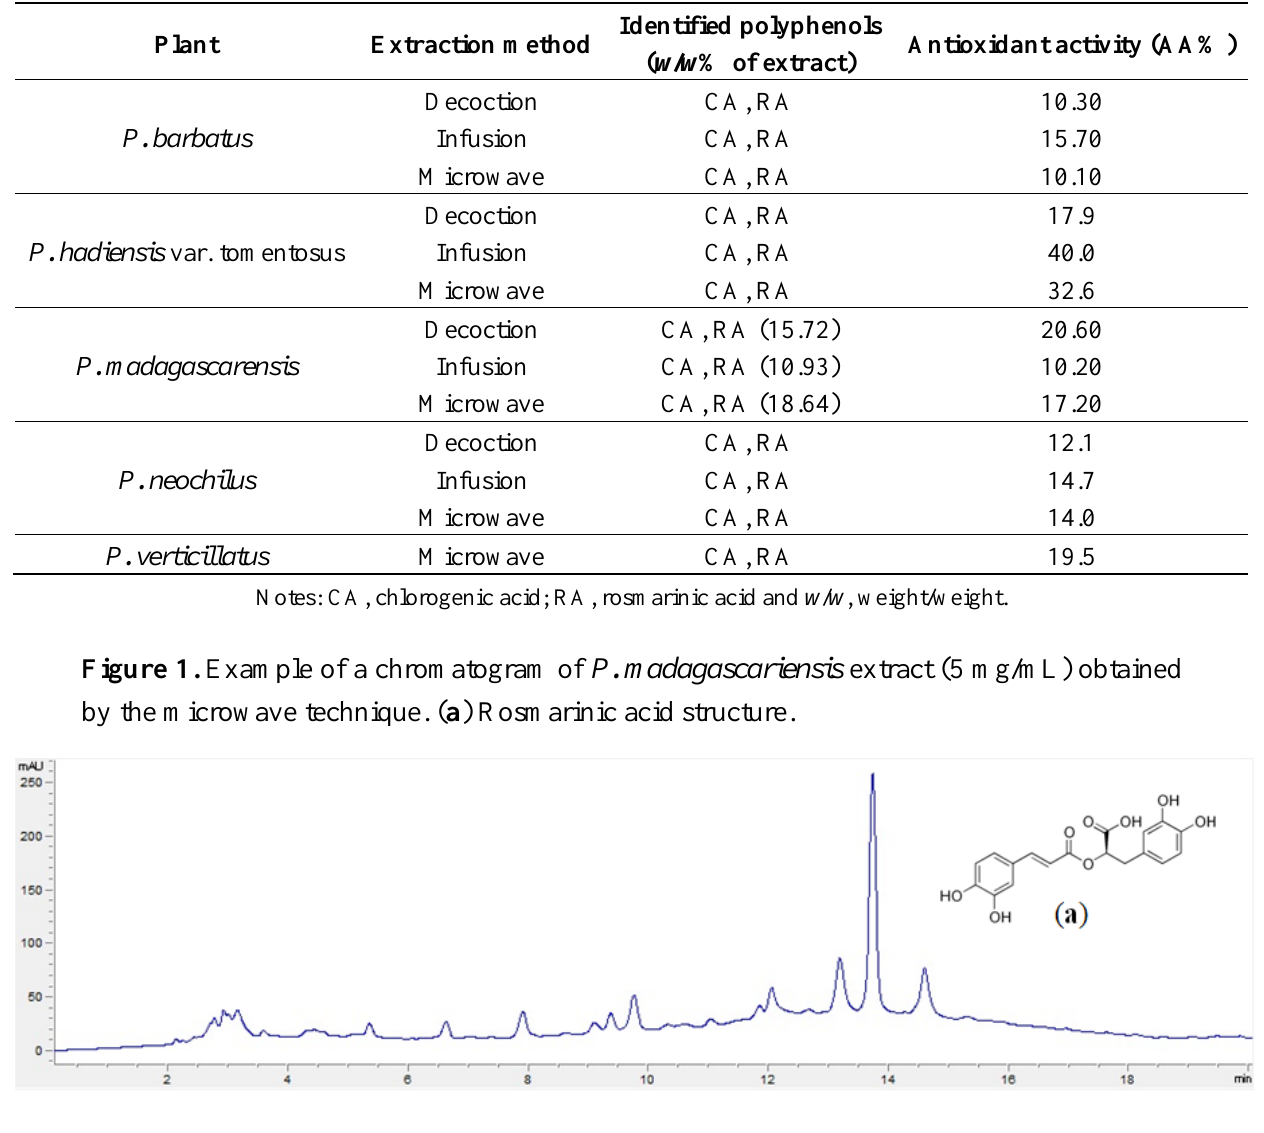
Table 2. Identified polyphenols and antioxidant activity of prepared aqueous Plectranthus extracts.